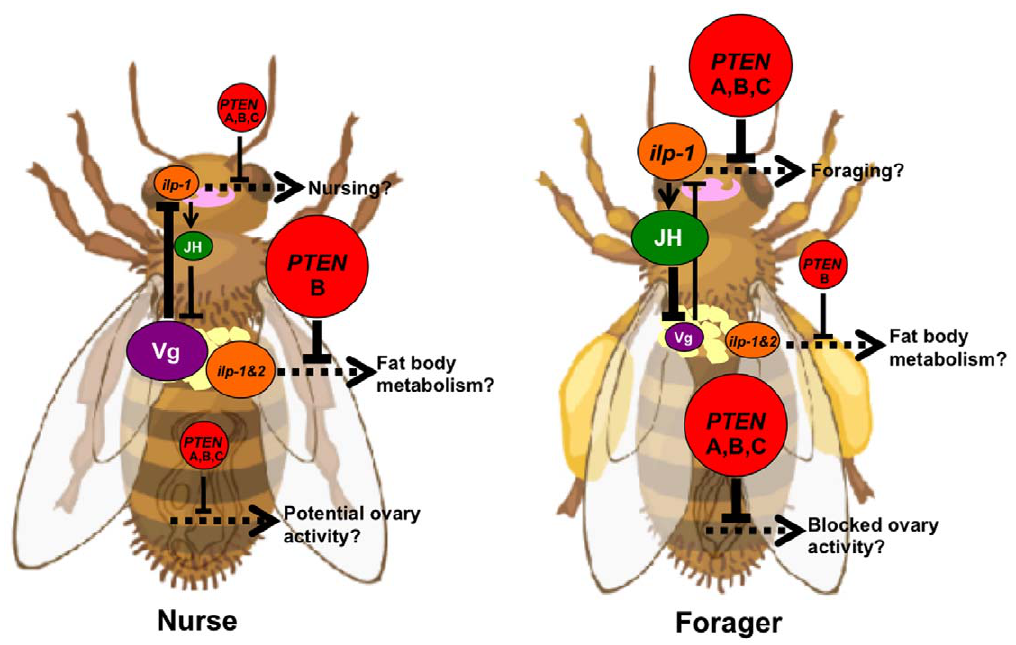
Figure 6. Possible tissue-specific PTEN functions in a regulatory network of honey bee behavior. In brain and ovary, PTEN (red circles) isoforms A, B and C, which could potentially down-regulate insulin/insulin-like signaling (IIS), are more abundant in foragers than in nurses. However, foraging behavior is positively associated with IIS via the release of insulin-like peptide 1 ( ilp-1 , orange ellipse) in the brain (pink) [32]. Ilp-1 may cause juvenile hormone (JH, green ellipse) levels to increase [91]; JH is also positively correlated with foraging behavior [94] and may enhance IIS by feedback suppression of vitellogenin (Vg, violet ellipse), a proposed negative regulator of IIS [34],[86],[92],[93]. These relationships contradict the repression of IIS by elevated PTEN in forager brain tissue. In contrast, suppressed IIS by PTEN in ovary tissue is consistent with the reduced reproductive propensity of foragers [31]. In fat body (yellow), PTEN isoform B, ilp-1 and insulin-like peptide 2 ( ilp-2 ) are elevated in nurses compared to foragers (K. Ihle, unpublished data; and results in this paper), but effects on metabolic biology are currently unclear. The ilp gene products from fat body or brain may also take part in remote signaling to other organs [32]. In this illustration, larger-size circles/ellipses, and thicker arrows (positive)/ blocked arrows (negative) denote higher levels of expression, enhancement and suppression, respectively. Dotted arrows indicate the yet unresolved effects on worker phenotypes.